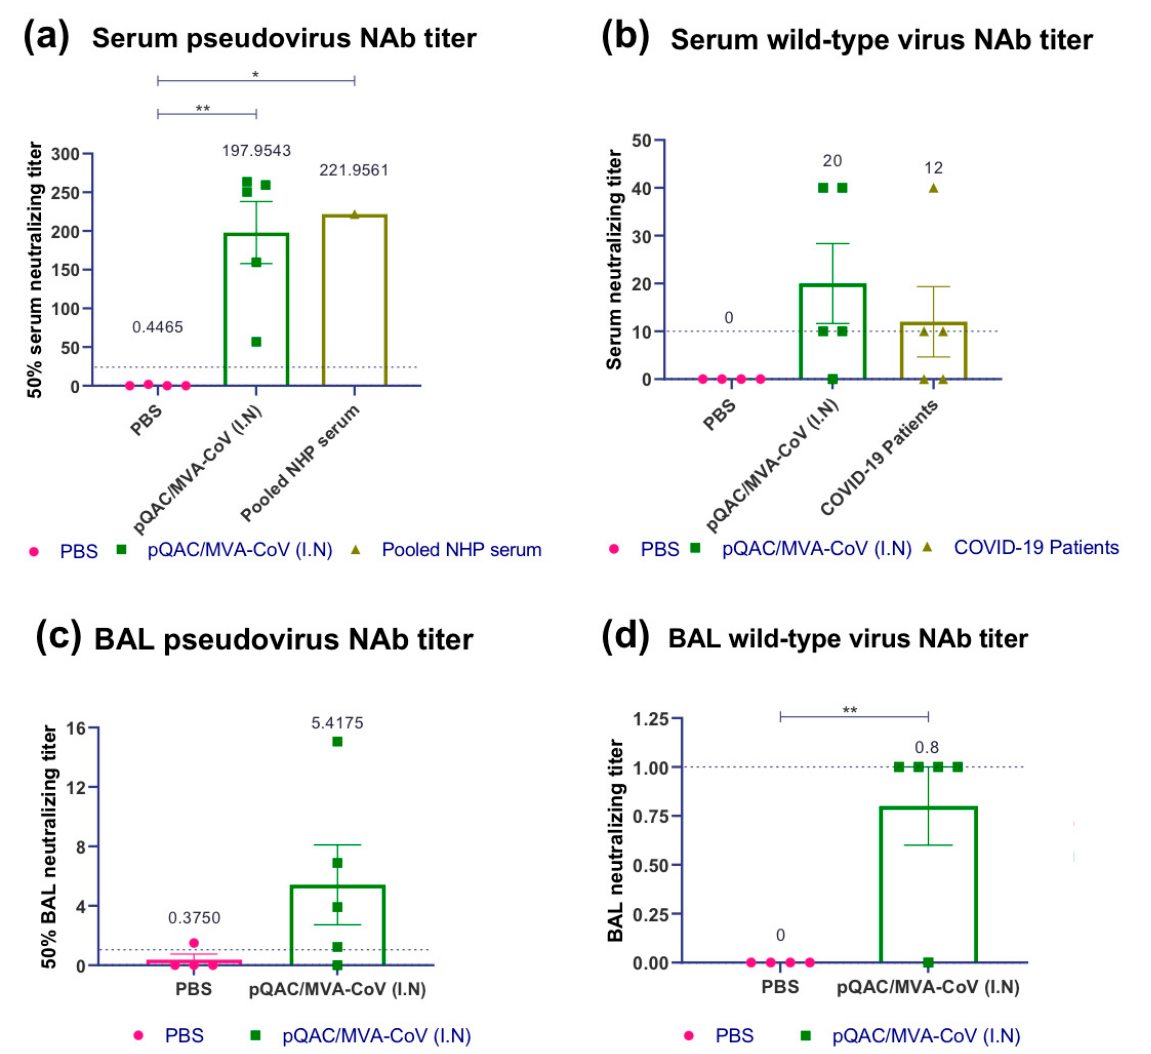
Figure 4. Heterologous vaccine strategy elicits SARS-CoV-2 neutralizing antibody responses. Groups of C57BL/5 mice were either unvaccinated (PBS) or immunized with pQAC/MVA-CoV (I.N). Serum and BAL samples were collected 3 weeks post boost. ( a ) 50% serum neutralization titer of pseudo-virus expressing SARS-CoV-2 spike, ( b ) serum neutralization titer of wild-type SARS-CoV-2, isolate USA-WA1/2020, ( c ) 50% BAL neutralization titer of pseudo-virus expressing SARS-CoV-2 spike, and ( d ) BAL neutralization titer of wild-type SARS-CoV-2, isolate USA-WA1/2020. Significance (*, p < 0.05; **, p < 0.01) was determined by one-way ANOVA. Data show mean ± SEM. The dotted line indicates the lower limit of detection.